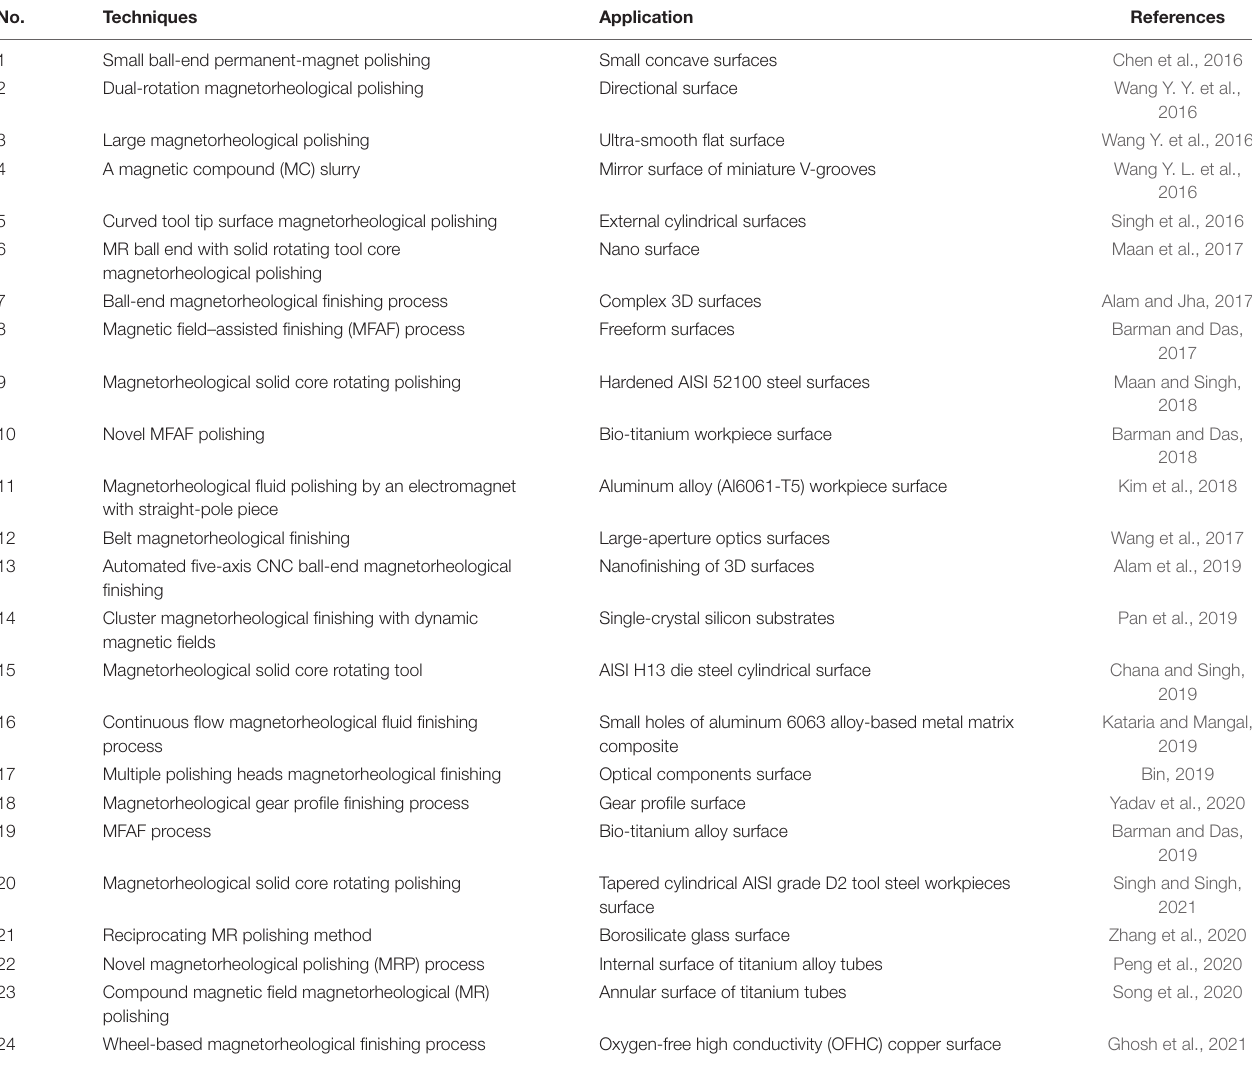
TABLE 1 | The techniques and application of MRF surface polishing equipment in 2016–2020.